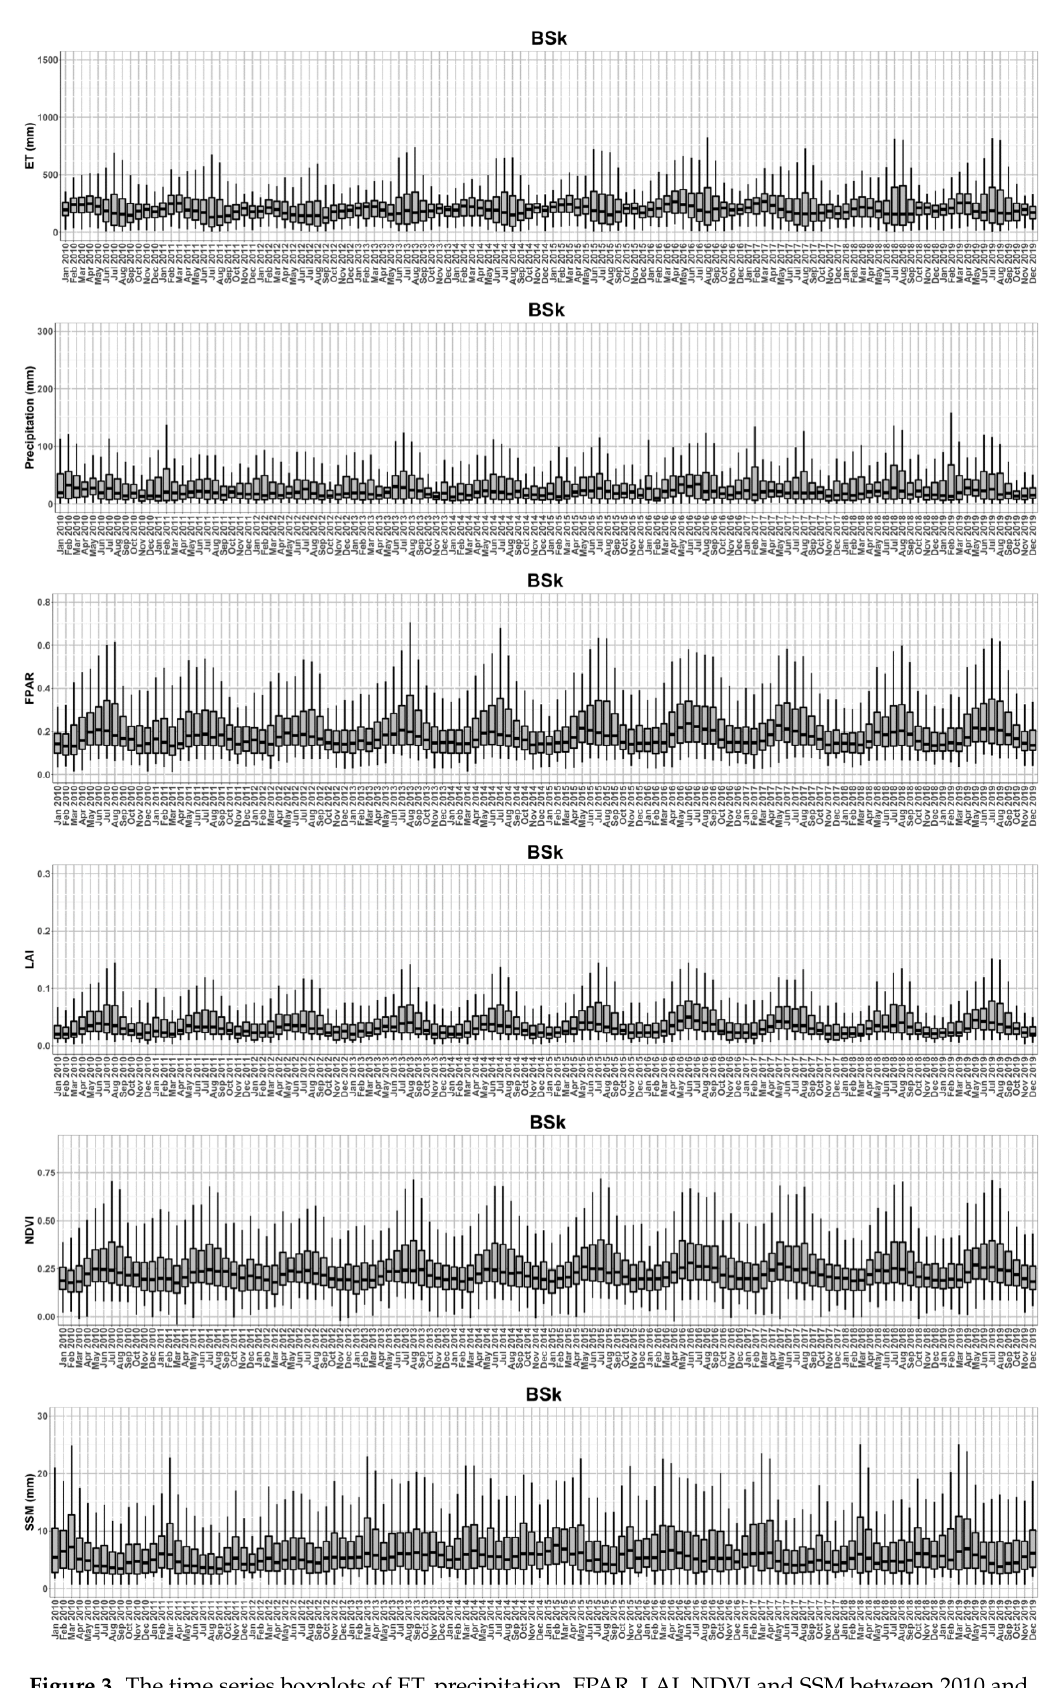
Figure 3. The time series boxplots of ET, precipitation, FPAR, LAI, NDVI and SSM between 2010 and 2019 for BSk.